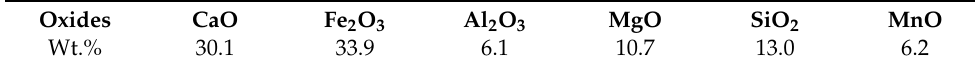
Table 6. Chemical composition of synthetic